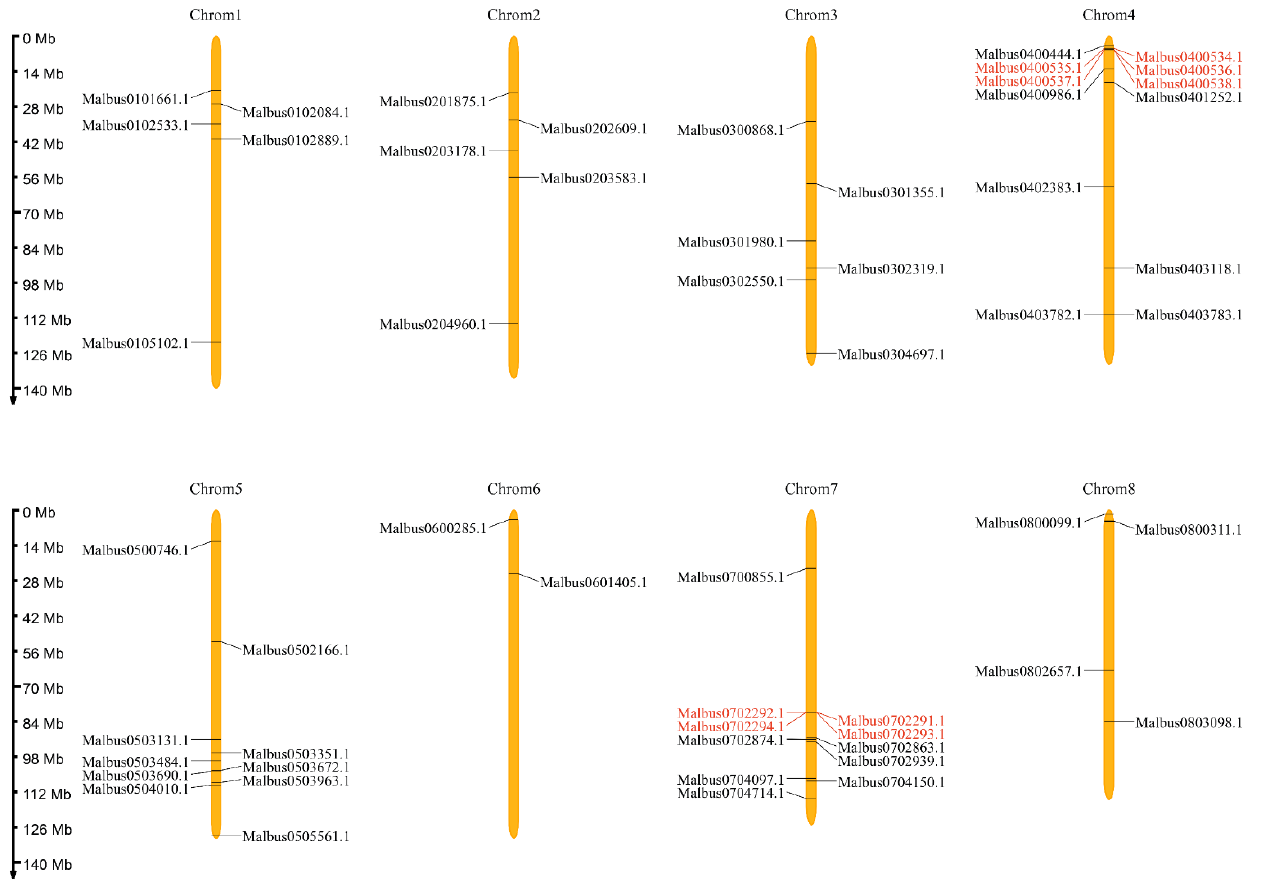
Figure 2. Chromosomal distribution and position of 55 MaGRAS genes identified in the M. albus genome. Eight chromosomes are indicated in orange columns, and black lines indicate the position of each MaGRAS genes. Red lines represent the tandemly duplicated genes.